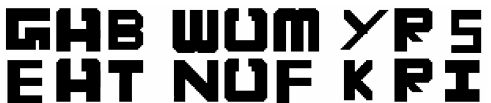
Figure 13. The noise-free test set with flipped context for the CINET(2) classifier.